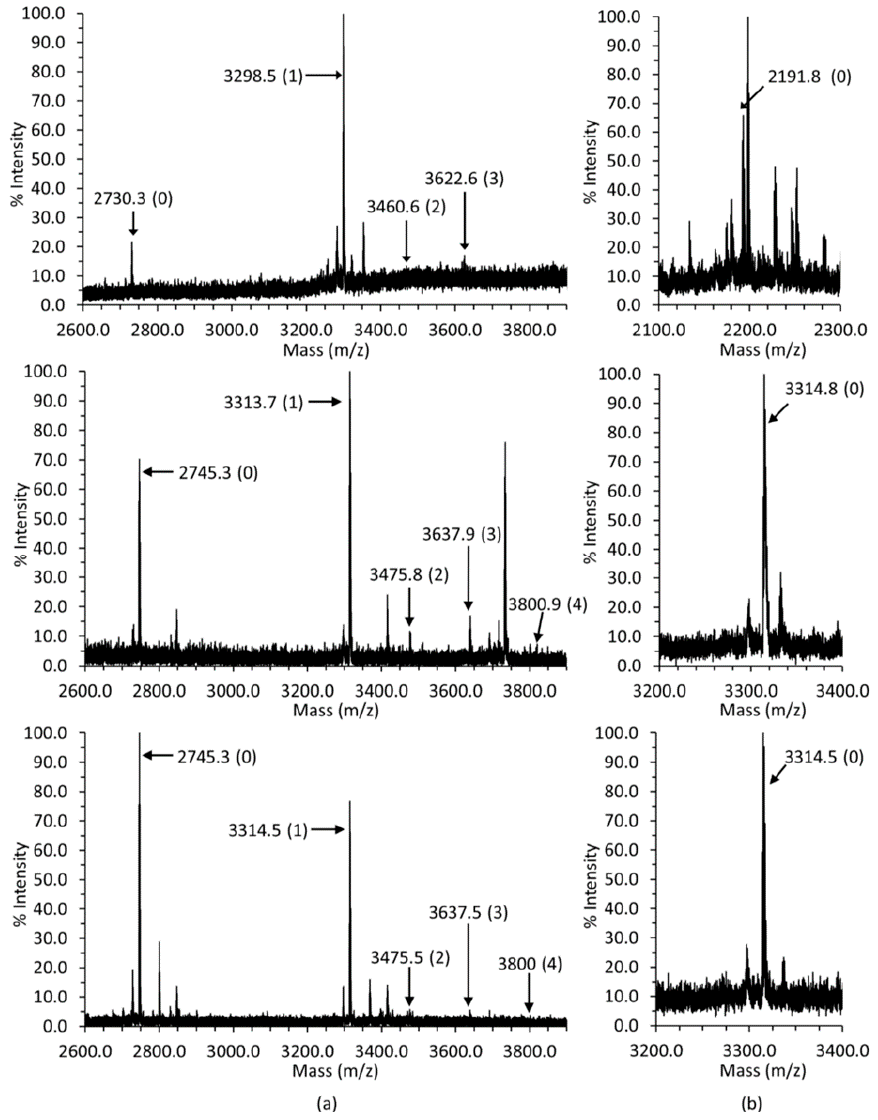
Figure 1. The mass spectra of bovine ( top ), mouse ( middle ) and rat Casq1 ( bottom ). ( a ) Calsequestrin 1 (Casq1) glycosylation spectra. The mass of each peak corresponding to either the non-glycosylated peptide or a glycopeptide is labeled, with each mannose contributing an extra 162 m / z . The parenthetical number, ( n ), associated with each mass indicates the number of mannose present, except the case of the non-glycosylated peptide, which does not have any sugars attached. The GlcNAc 2 is implied, i.e., ( n ) denotes GlcNAc 2 Man ( n ) ; ( b ) the C-terminal peptide masses. The parenthetical zero indicates no phosphoryls are present. The spectra for the peptides were collected using a 4800 MALDI TOF/TOF Analyzer (Applied Biosystems). All spectra were collected in negative reflector mode.